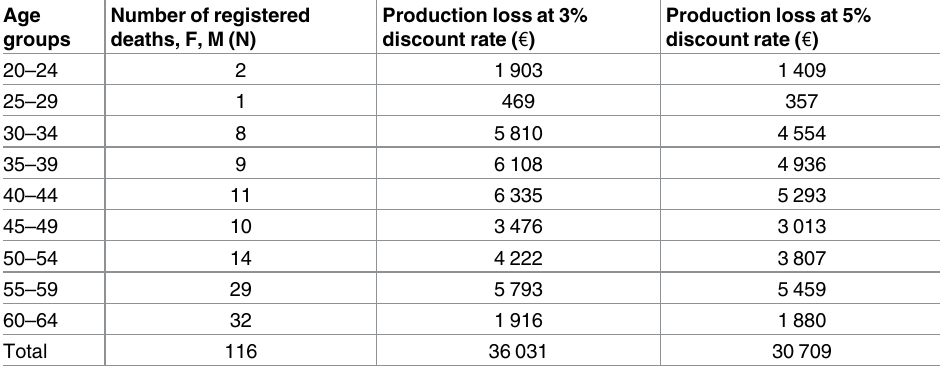
Table 4. Cost of premature death due to HR HPV-attributable cancers(presented in € 1000).